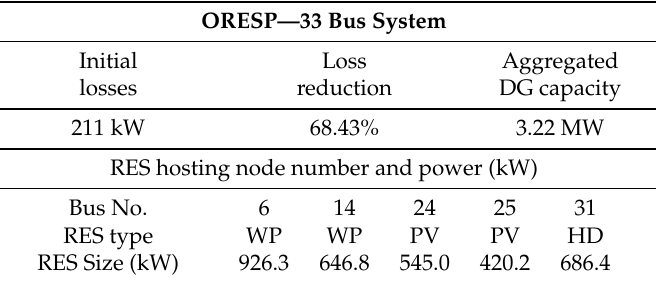
Table 3. ORESP results for 33 bus